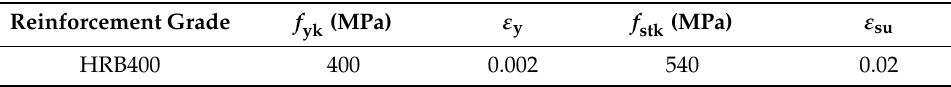
Figure 8. Specimen ZM01 (dimensions in mm).